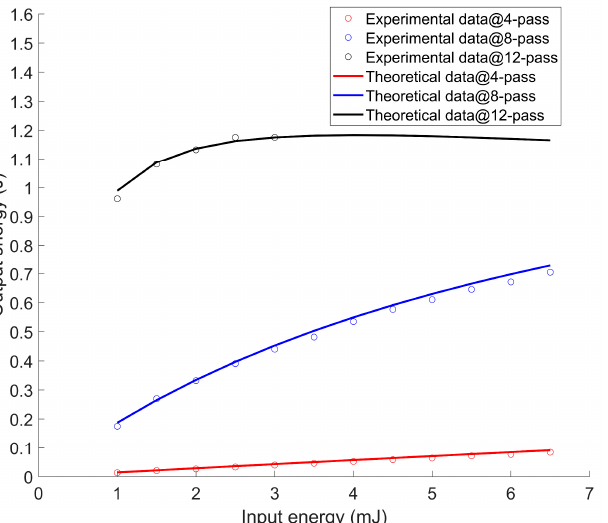
Figure 8. Multi ‐ pass amplification energy comparison between theoretical calculations and experi ‐ mental results.